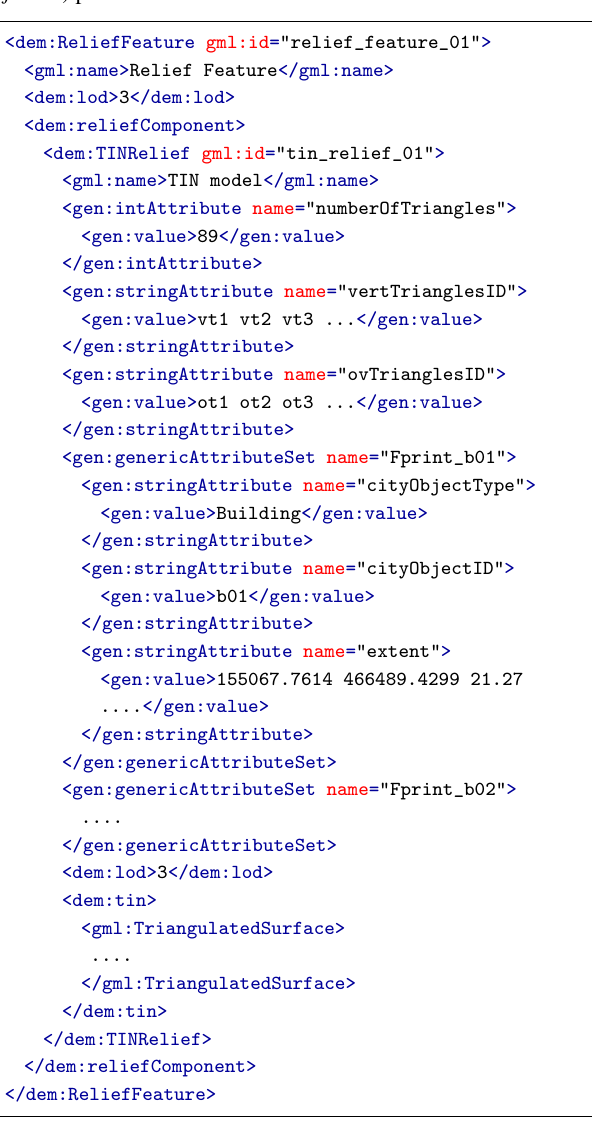
Table 1. Summary of the proposed terrain